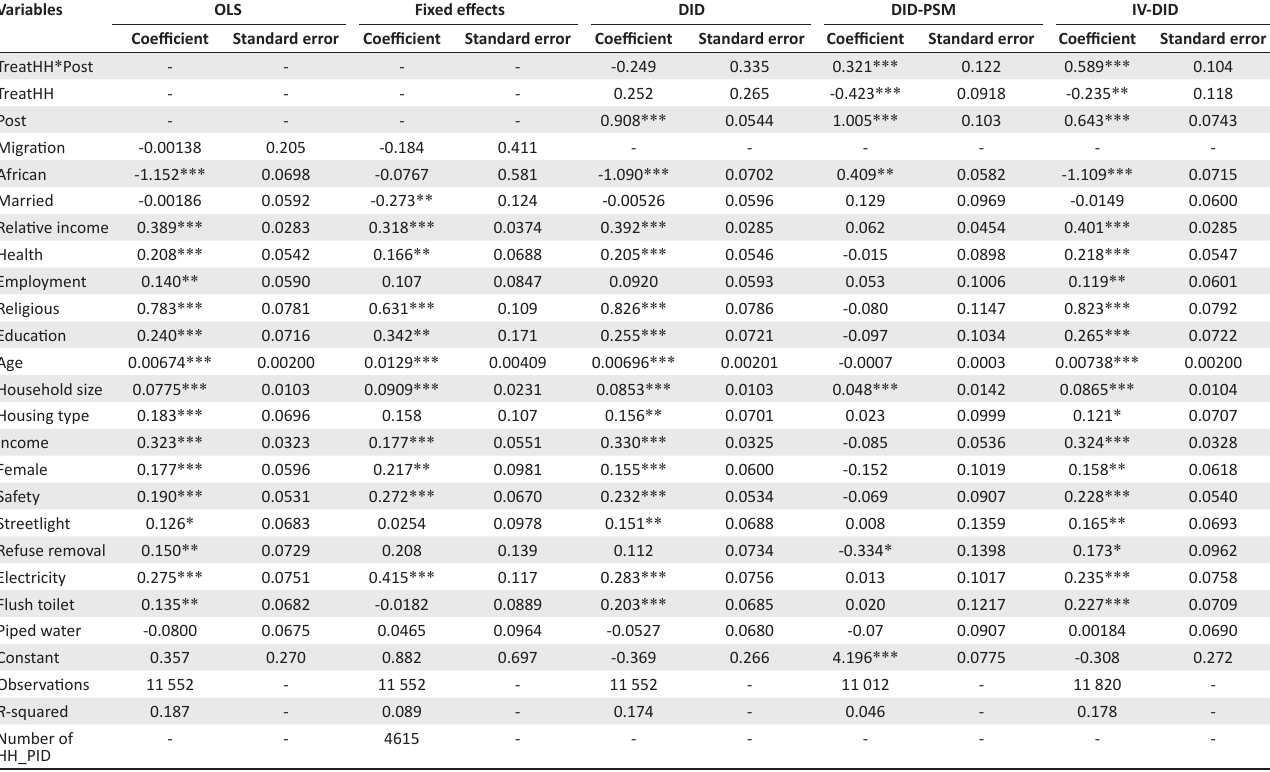
TABLE 5: Impact of migration on household’s subjective well-being. Variables OLS Fixed